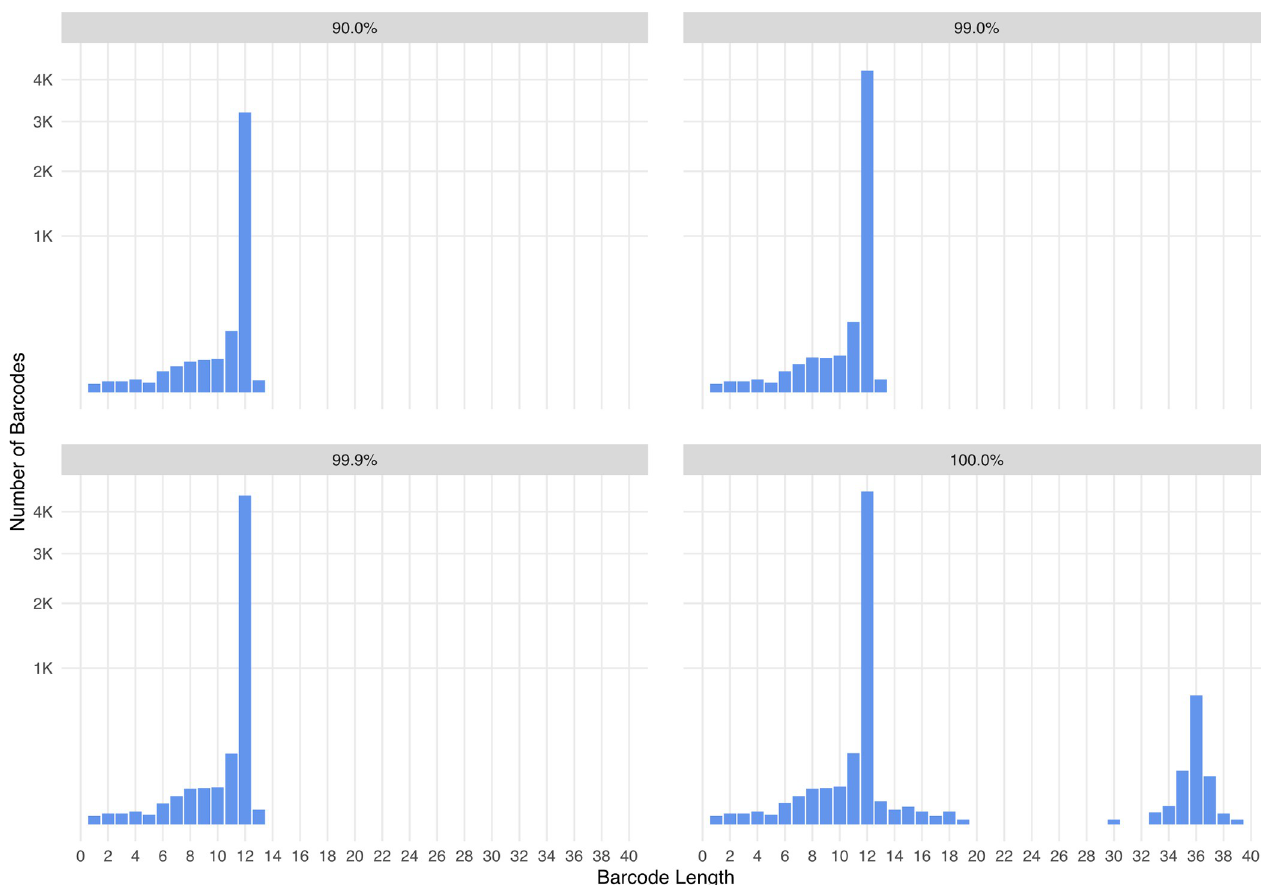
Fig 7. Barcode length distributions for 90%, 99%, and 99.9% sequencing reads cutoffs. Applying a cutoff for barcode abundance eliminates most recall of longer barcodes that were not intended in the original design for a 12-nucleotide barcode library. These barcodes are derived from the L3 clustering. The y-axis is square root-transformed so low values are more